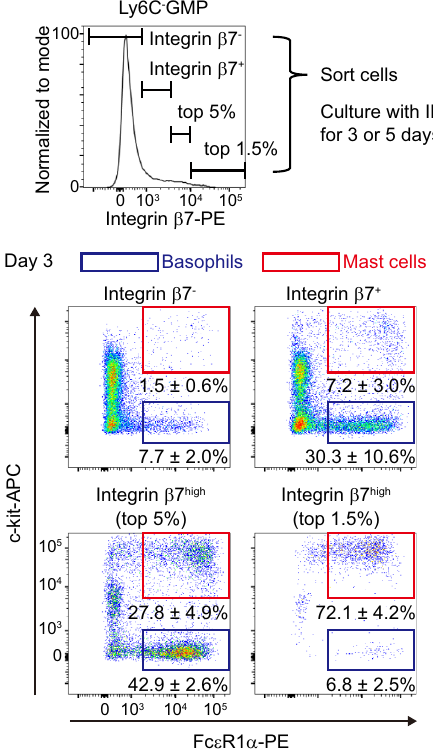
Fig.10|Ly6C - GMPswithveryhighexpressionofIntegrin β 7arebiasedtomast celldifferentiation. Ly6C - GMPsweresortedanddividedinto4groups:Integrin β 7 - cells,Integrin β 7 + cells(thosedidnotrankinthetop5%ofallLy6C - GMPs),cellswith highexpressionofIntegrin β 7(thoserankedbetweenthetop1.5%and5%),andcells withveryhighexpressionofIntegrin β 7(thoserankedinthetop1.5%).FACSgating strategies for sorting are shown in Supplementary Fig. 12. Cells were cultured in vitro in the presence of IL-3 for indicated periods of time, and then analyzed. FACS gating strategies for analysis are shown in Supplementary Fig. 14a. Numbers shown are mean percentages±SD of basophils, de fi ned as Fc ε R1 α + c-kit - (blue), and